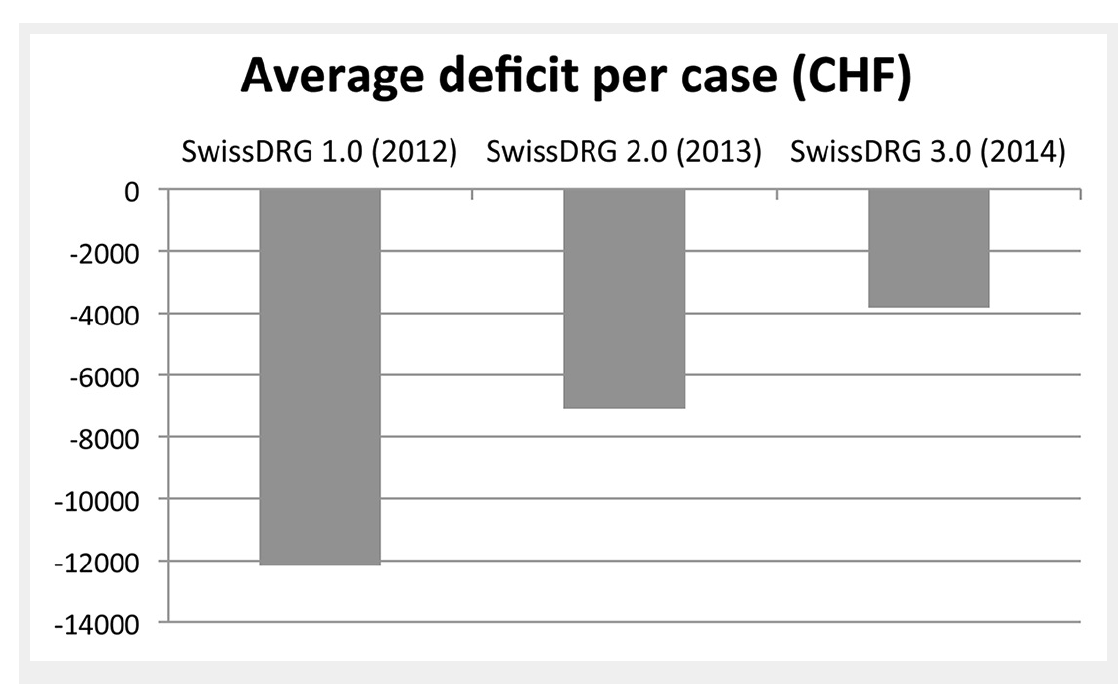
Average deficit under different SwissDRG catalogue versions. Average deficits were calculated as the mean of diagnosis-related group (DRG) revenue minus total costs per case. DRG revenue was determined by multiplying the effective case-mix points of the case’s DRGs as defined by the different catalogue versions (V1.0, 2014; V2.0, 2013; V3.0, 2014) by a base rate of 11300 CHF. Supplementary payments (“Zusatzentgelte”) were taken into